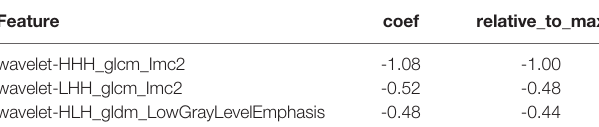
TABLE 2 | The selected features in radiomics model and weight